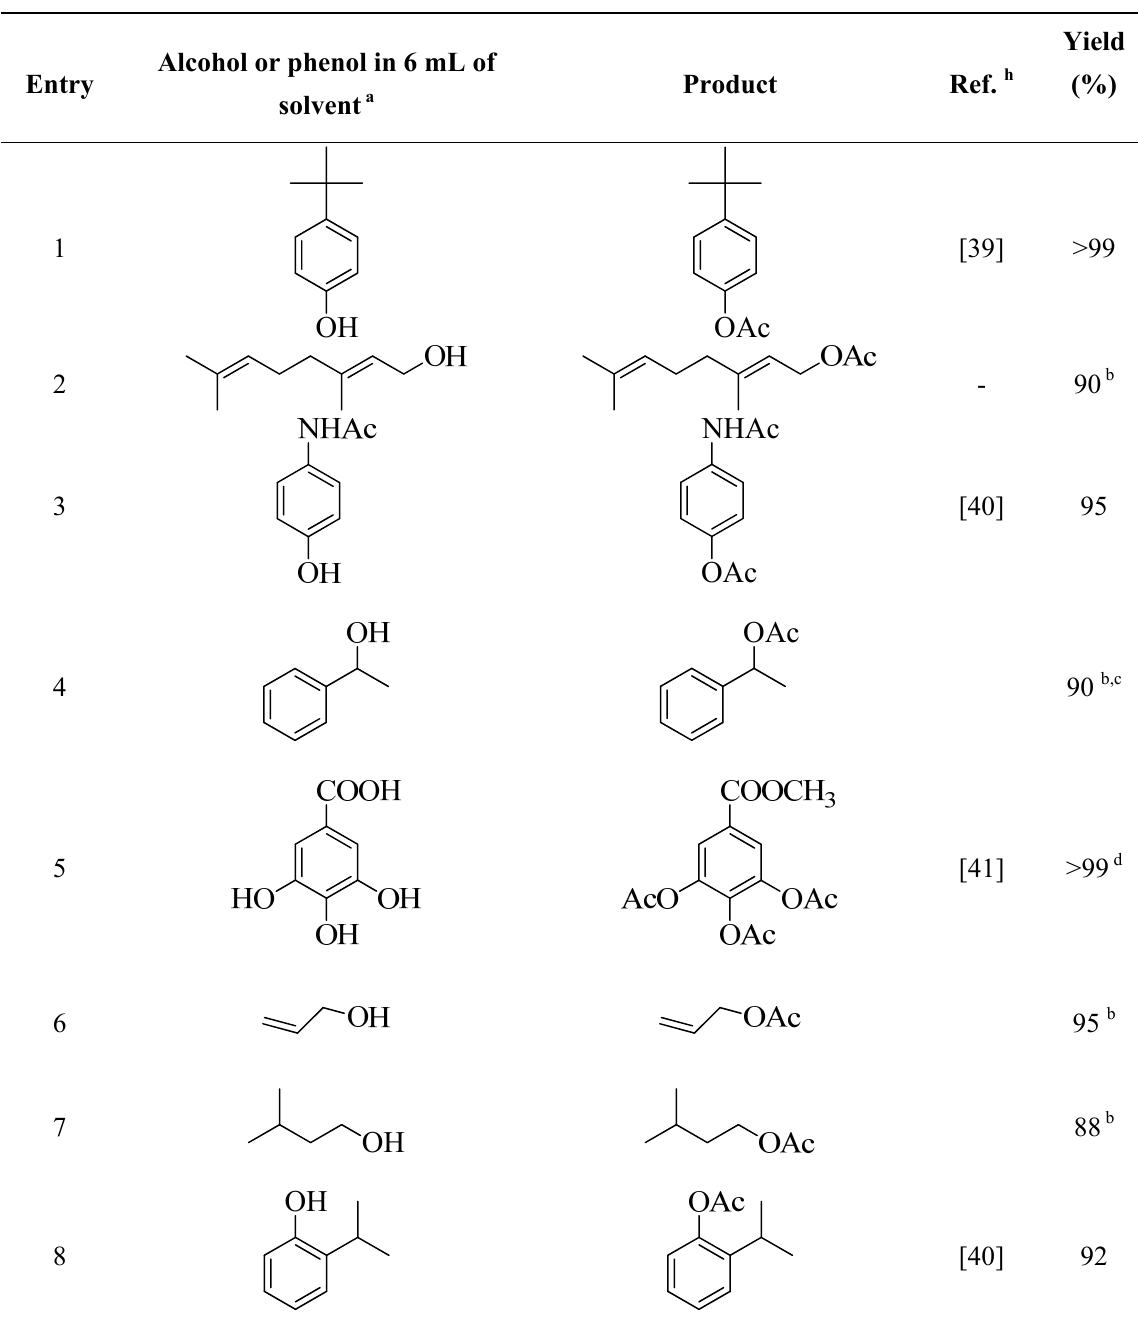
Table 4. Acetylation of alcohols and